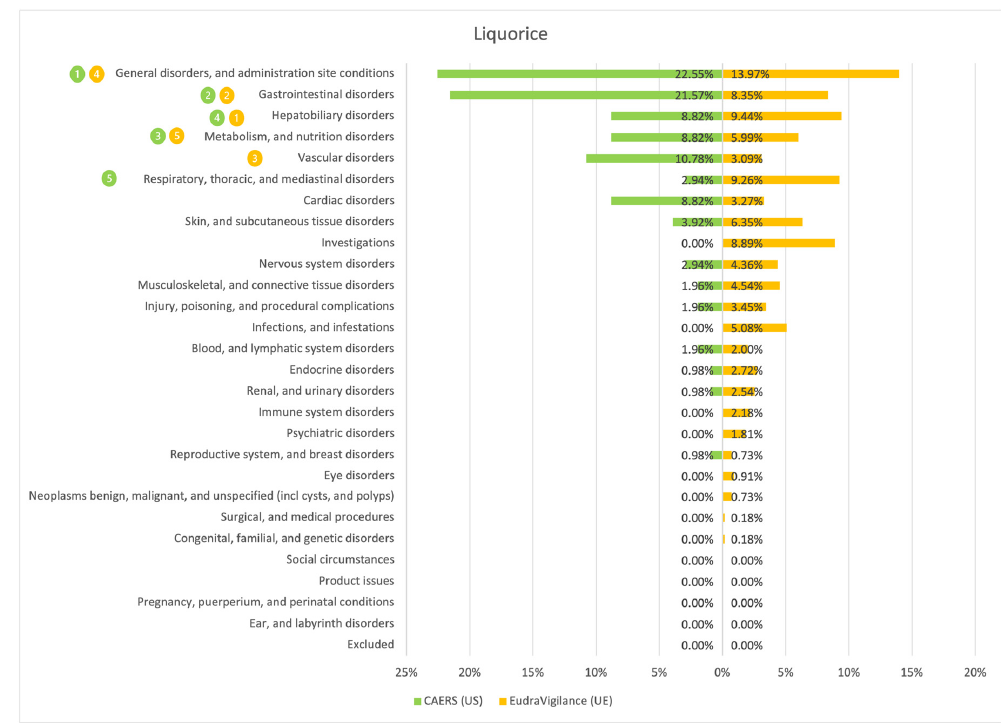
Figure 2. Summary of the frequency of reporting side effects of Liquorice in the US and EU registers. Data marked in green refer to the CAERS (US) database and yellow to the EudraVigilance (UE) database. Numbers 1–5 present the most commonly reported categories of adverse effects in descending order.